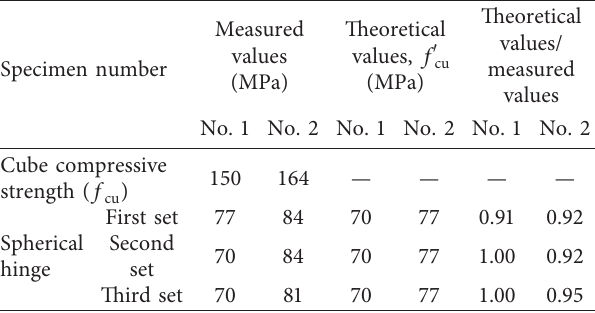
Table 3: Theoretical and measured values of compressive strength of spherical